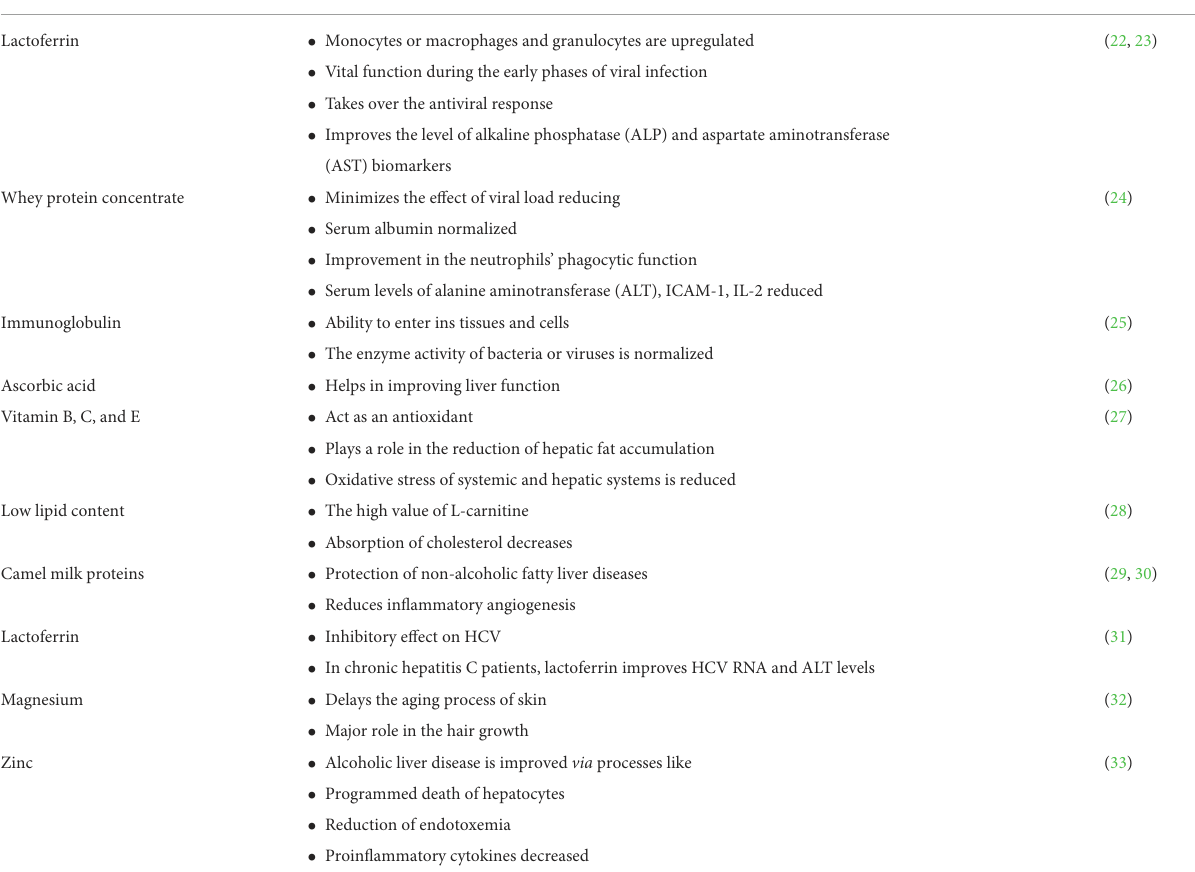
TABLE 2 Mechanism of action of bioactive components of camel